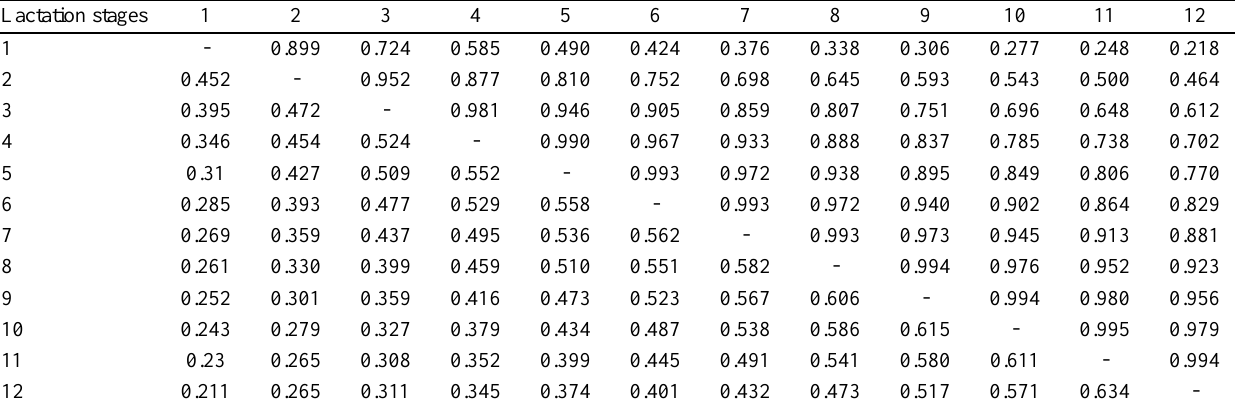
Table 4. The additive genetic (above the diagonal) and phenotypic (below the diagonal) correlations between test-day protein yield at different stages of lactation Lactation stages